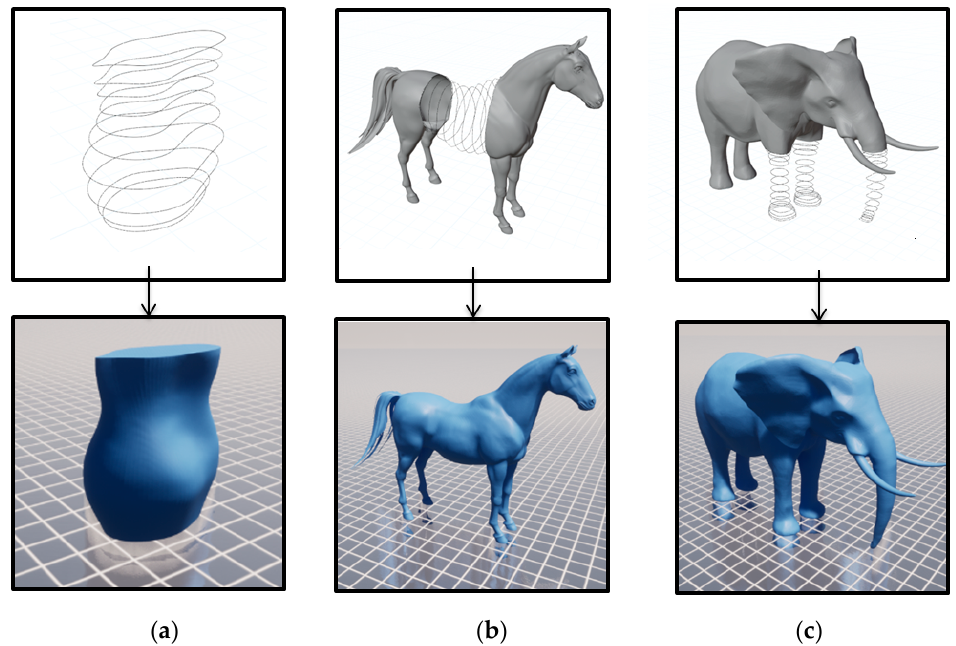
Figure 7. Surface shape generation from cross section curves by using the method proposed in this paper. ( a ) a smooth vase model, ( b ) a horse belly model, ( c ) front leg and nose models of an